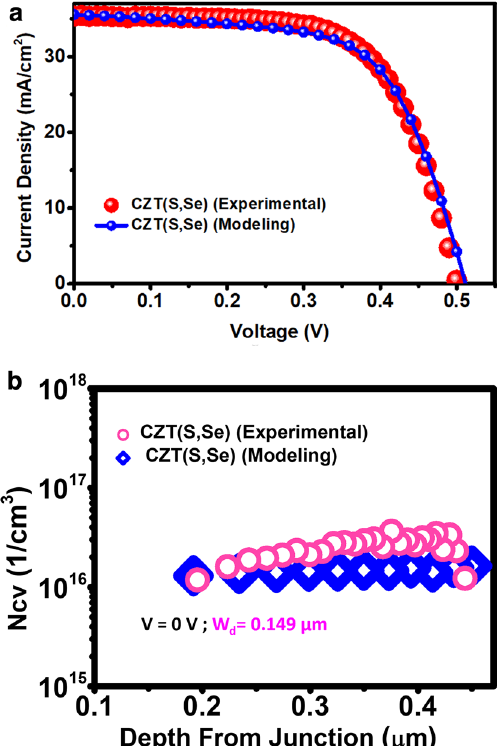
Figure 2. ( a ) Current density versus voltage curves for experimental and simulation results. ( b ) The C–V charge densities (N CV ) in the CZTSSe absorber layer at temperature of 300 K and frequency of 100 kHz.